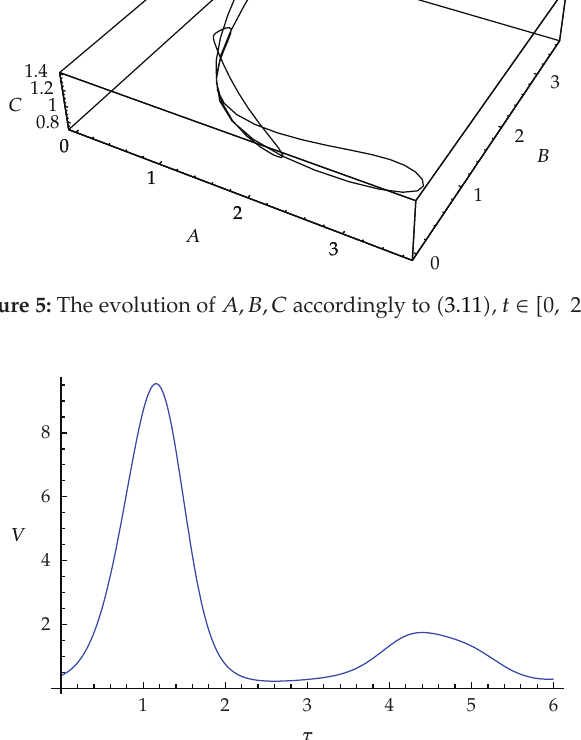
The scalar curvature has the